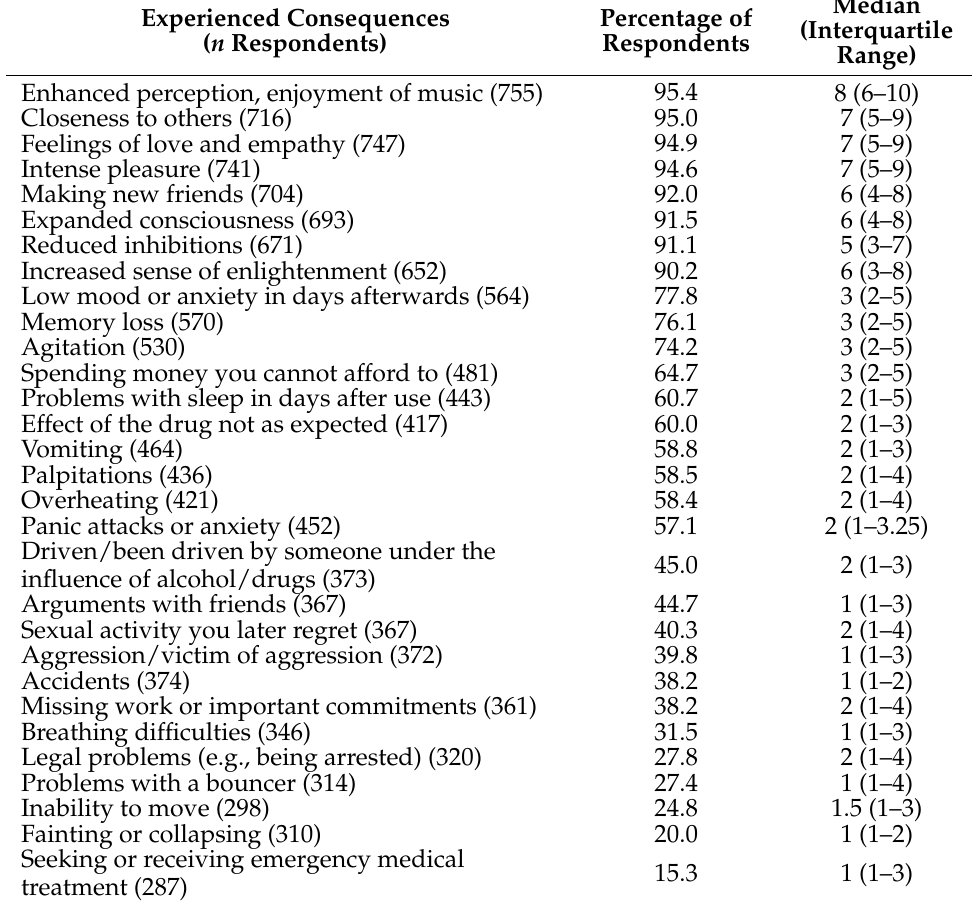
Table 6. Experienced consequences of the use of illicit drugs. Response options were from 0 (never) to 10 (every time). The number of respondents is shown for each experience. Data are presented as percentage of respondents who gave a response between 1 and 10. Hence, the remaining respondents answered ‘never’, i.e., had not had this experience. The median and interquartile range of those that had responded between 1 and 10 is also